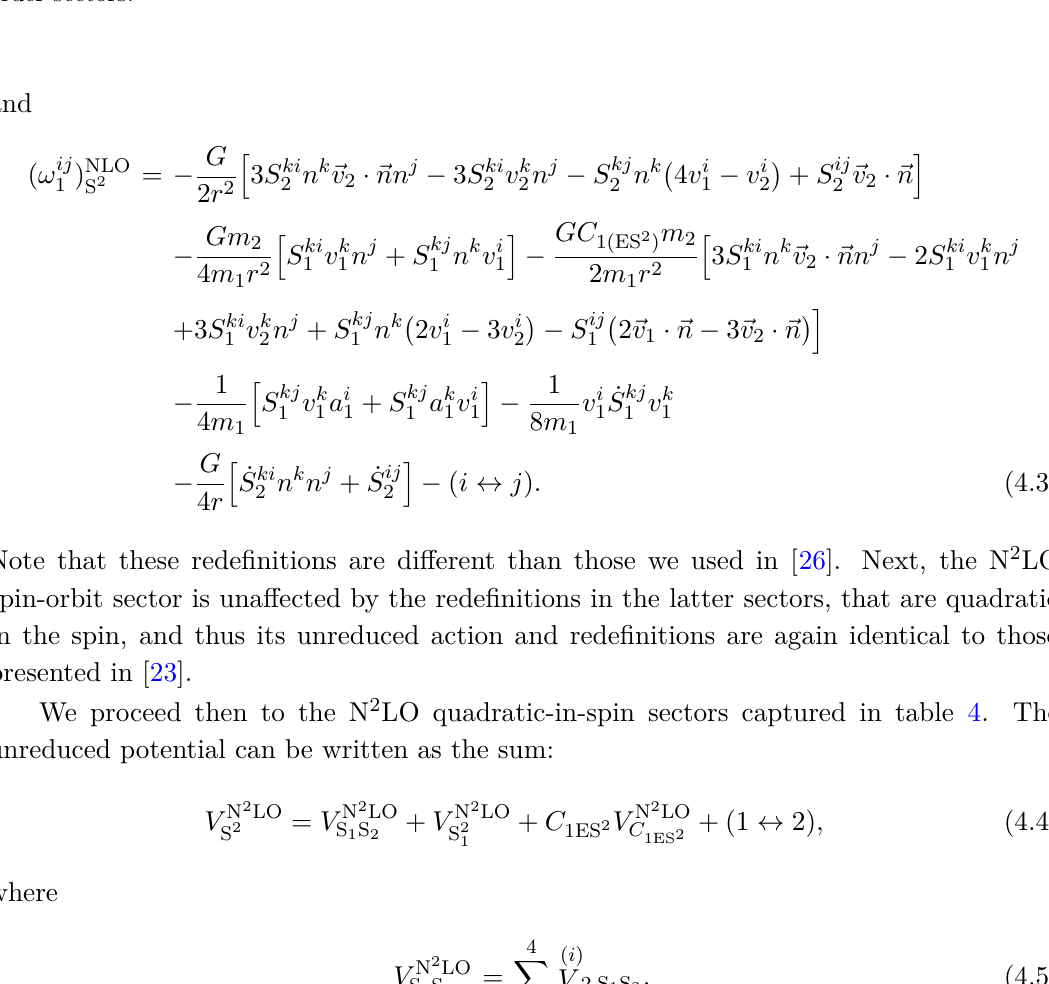
Table 4 . Contributions to the N 2 LO S 2 sector from position shifts and spin redefinitions in lower- order